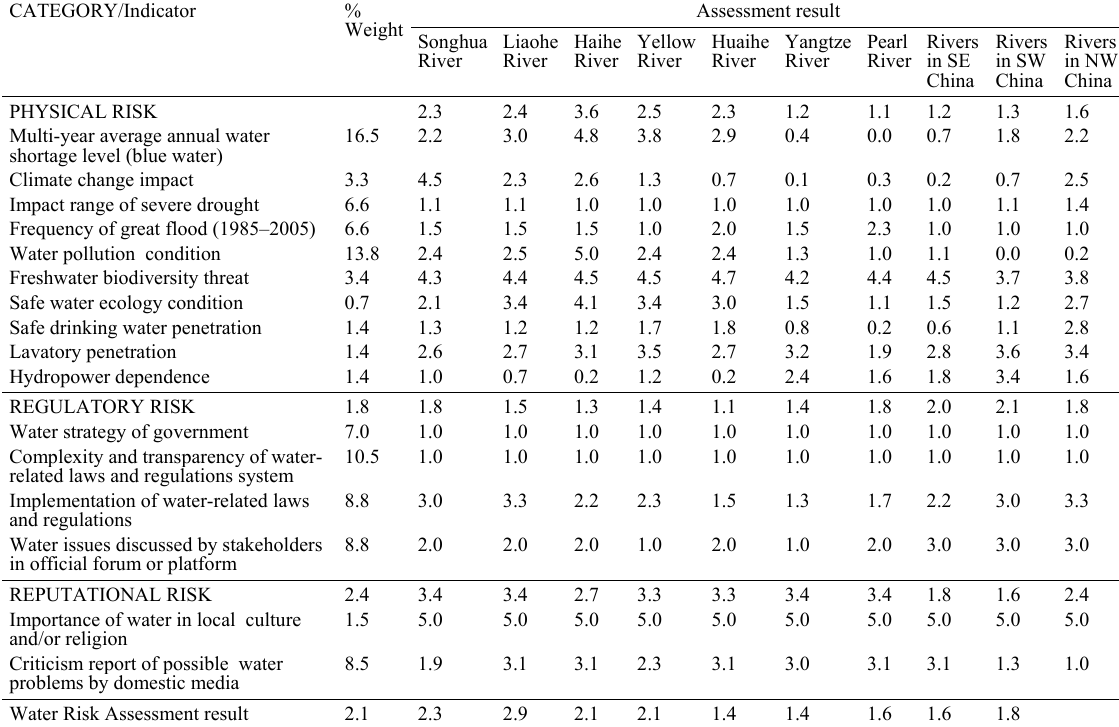
Table 2 Water risk assessment